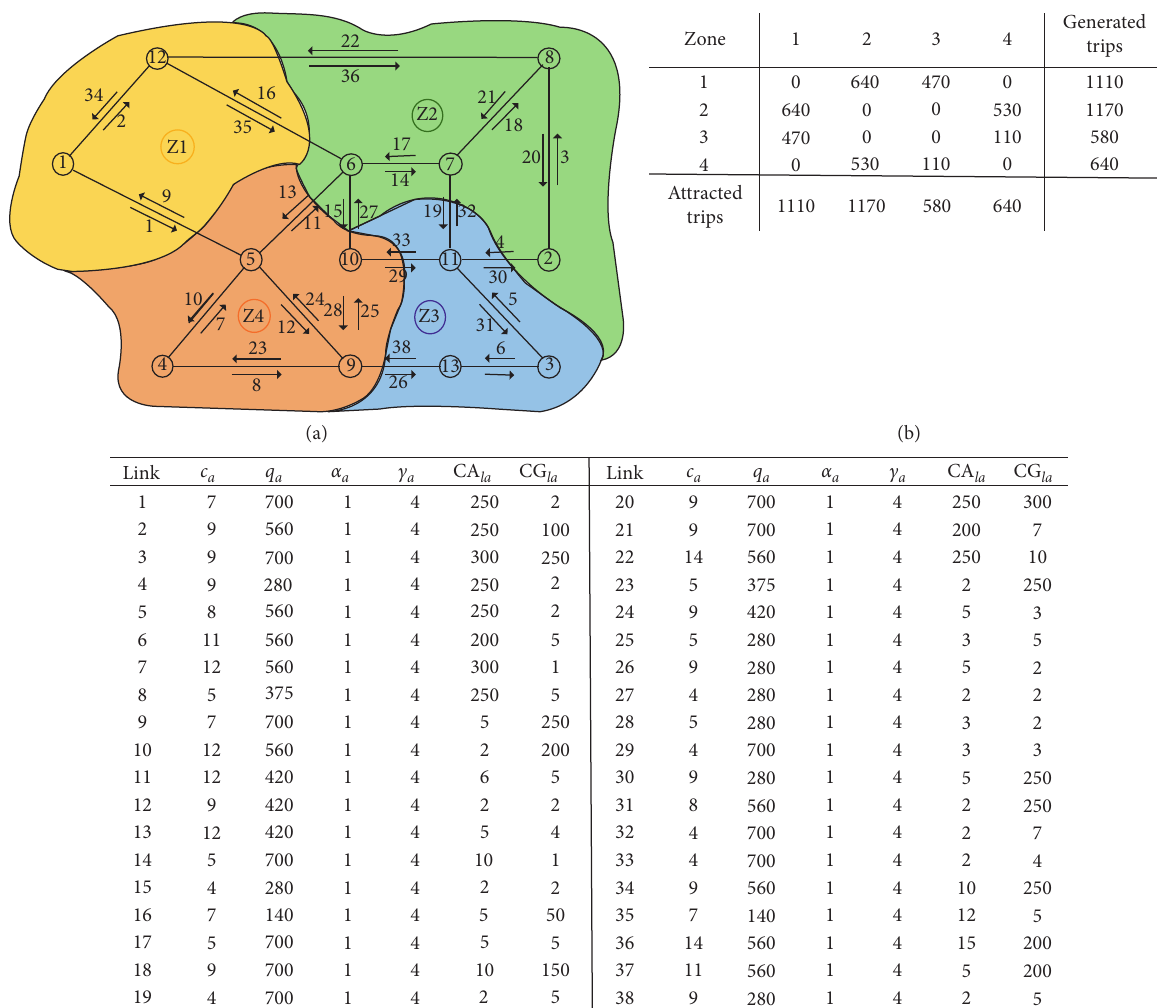
Figure 3: Nguyen-Dupuis network and its division into 4 traffic zones ( Z ) and the associated OD matrix.